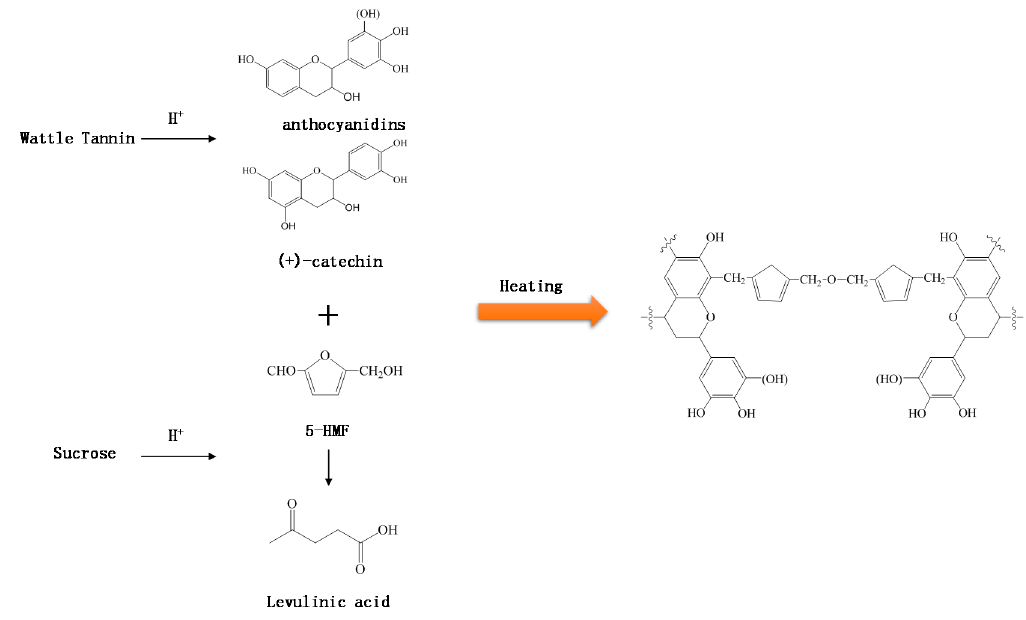
Figure 7. Possible reaction process between wattle tannin and sucrose by adding sulfuric acid.